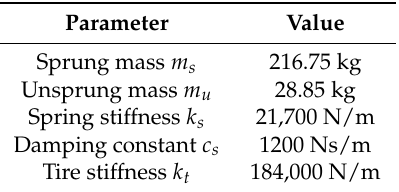
Table 1. Parameters of the vehicle suspension